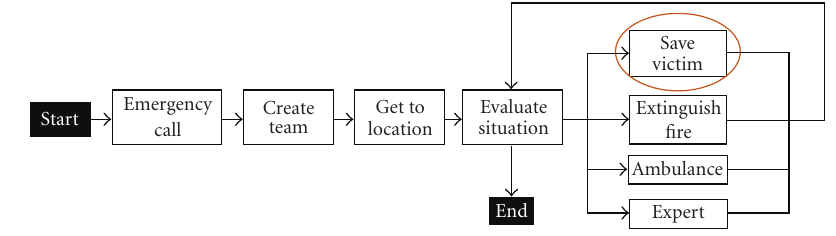
Figure 4: Interaction structure in